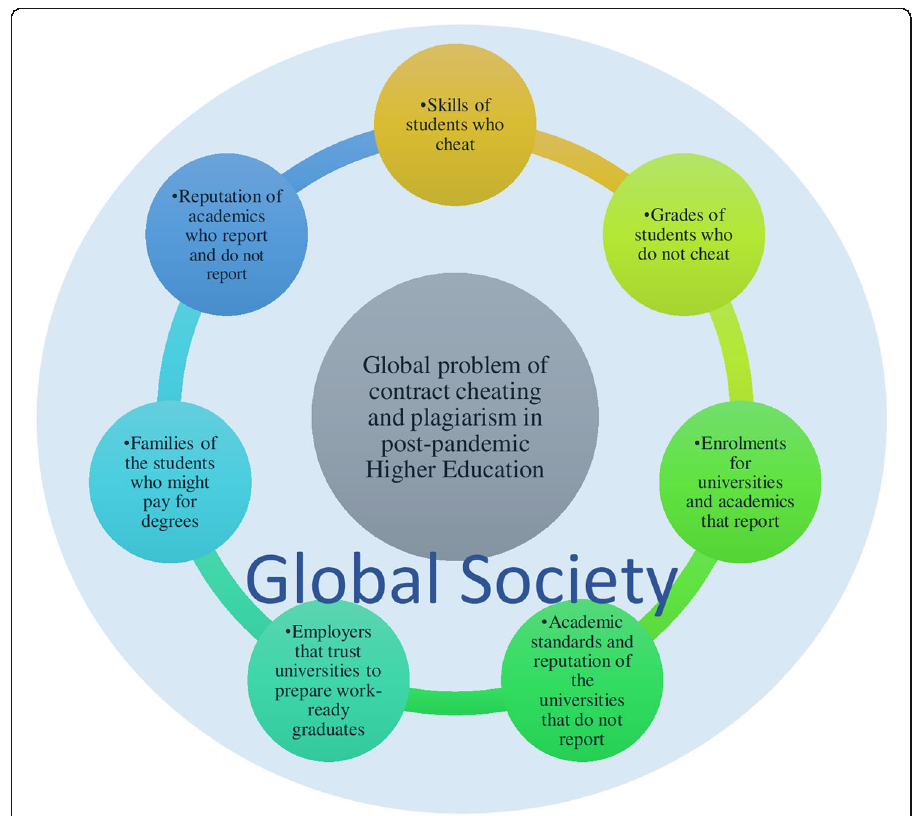
Fig. 1 Growing scope of impact of contract cheating in higher